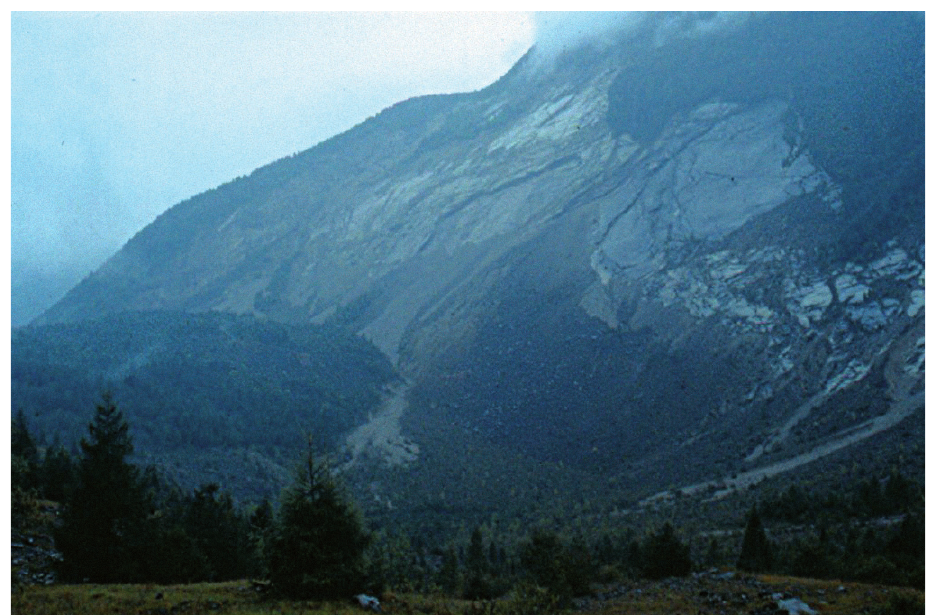
Figure 2. The wall of the arch-dam rising to 262 m from the bottom of the Vaiont canyon